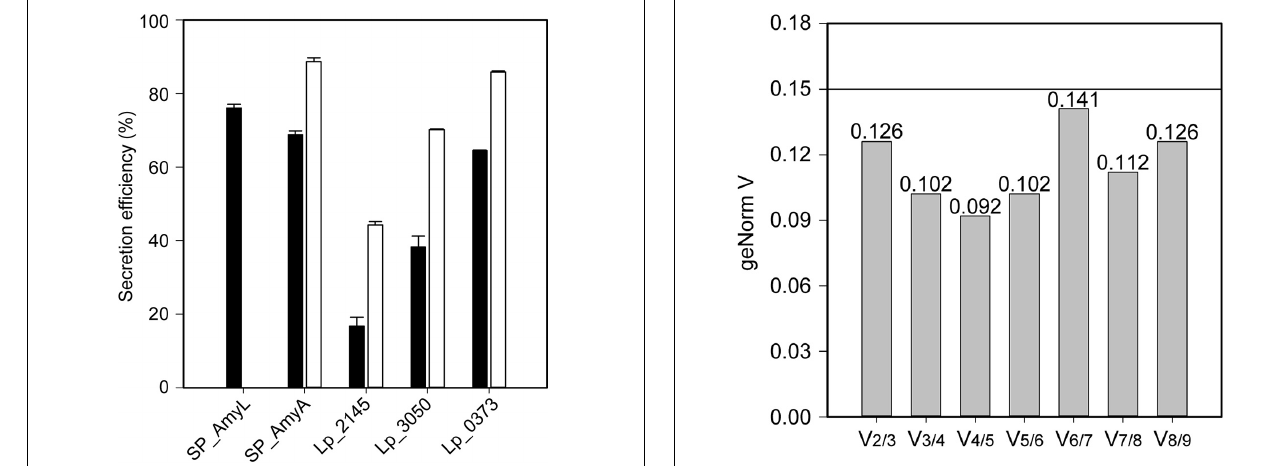
FIGURE 3 | Secretion efficiencies of recombinant L. plantarum WCFS1 harboring various expression plasmids of AmyL (black bars) and AmyA (white bars) at 3 h after induction. Values given are the average values from at least two independent experiments and the error bars indicate the standard deviation.